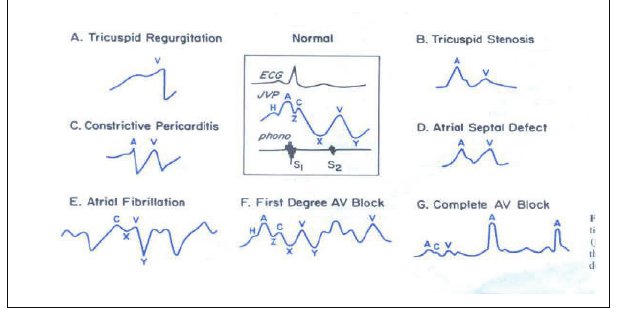
Source : Adapted from O’Rourke RA, et al. General examination of the patient, Hurst’s, the heart. 8th ed. p. 238–242. 19 Schematic representation of the normal jugular venous pulse (JVP), four types of abnormal JVPs and the JVPs in three arrhythmias FIGURE 2: Jugular venous pressure waveform.